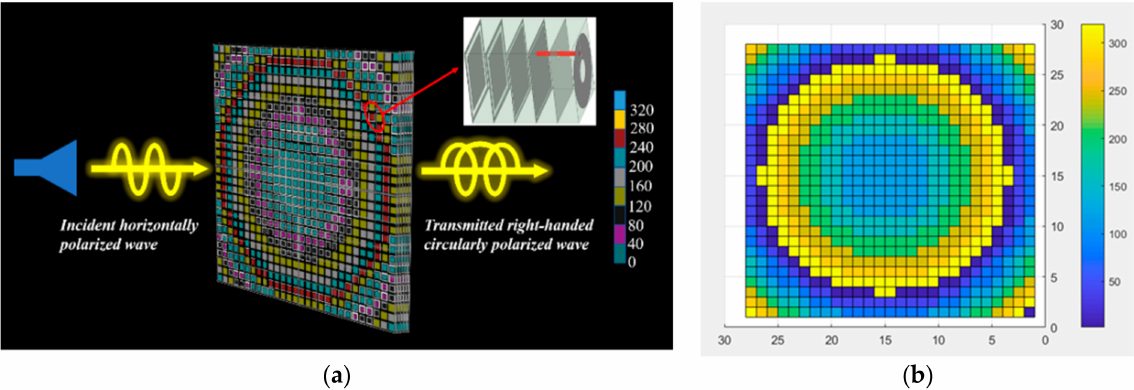
Figure 4. The designed transmit-array lens antenna with proposed elements: ( a ) schematic diagram of the transmit-array lens antenna; ( b ) phase distribution of the transmit-array antenna in